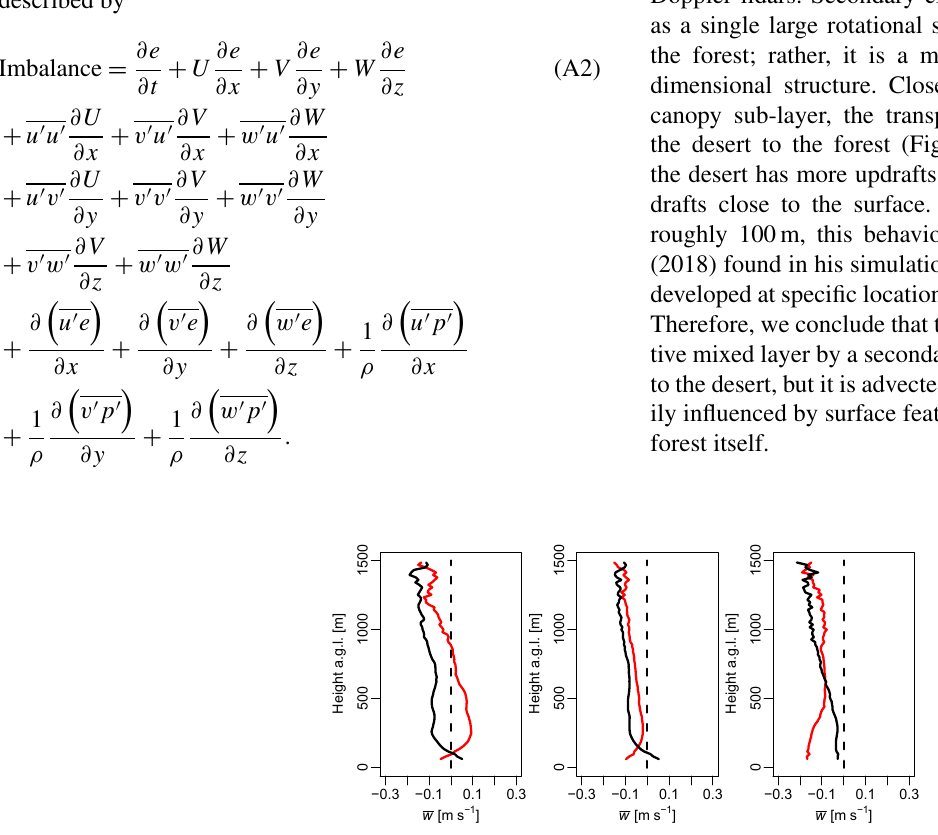
Figure A1. Vertical mean velocity profile averaged from 18 to 29 August (only times with both instruments simultaneously online and the nearest three range gates are discarded). Left to right: 4h window centered on noon, daytime (sunrise to sundown) and nighttime (sundown to sunrise). The forest is shown as a solid red line, the desert as solid black line and a vertical line at w = 0 as a black dashed line. Note that near the surface, the desert always has larger w , but only during the noontime with the updrafts of the forest is there a change in